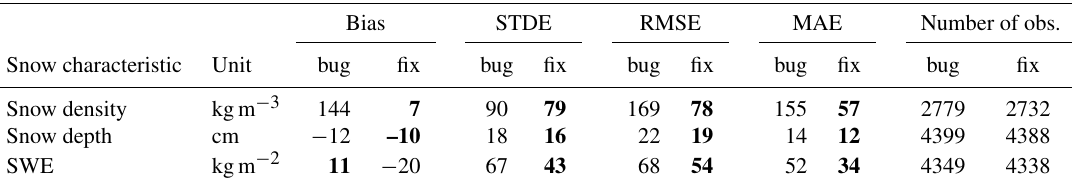
Table 6. Bias, STDE, RMSE and MAE of snow density, snow water equivalent (SWE) and snow depth computed from 1 January 2014 to 31 January 2015 with the bug and with the fix for the bug identified in the RDRS (and in the operational RDPS) when estimating the maximum value for snow density as a function of snow depth. Best score for each snow characteristic is shown in bold. Number of observations used for the evaluation is shown in the last two columns. Bias STDE RMSE MAE Number of obs. Snow characteristic Unit bug fix bug fix bug fix bug fix bug fix Snow density kgm − 3 144 Snow depth cm − 12 SWE kgm −